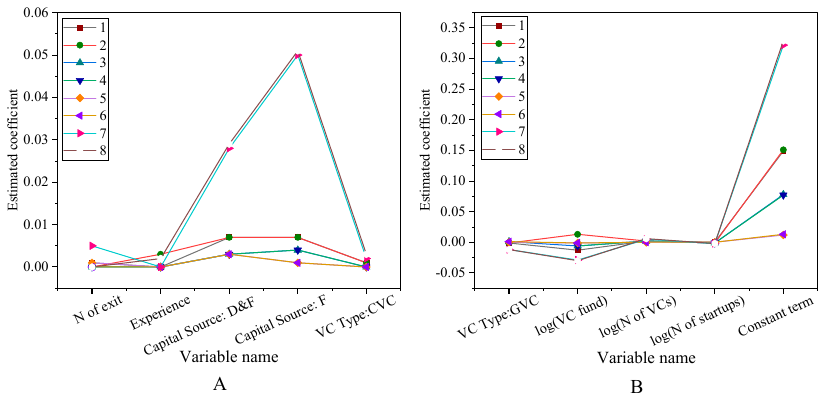
Figure 10. Test results of risk investment social network centrality factors ( A ) The first five variables. ( B ) Other variables.